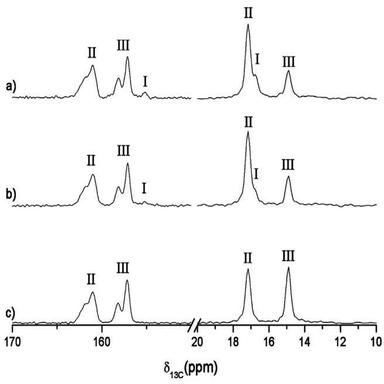
High and low ppm region of 13C ss-NMR spectra of samples a) A, b) B and c) C, indicating the presence of the different polymorphs of OLZ.